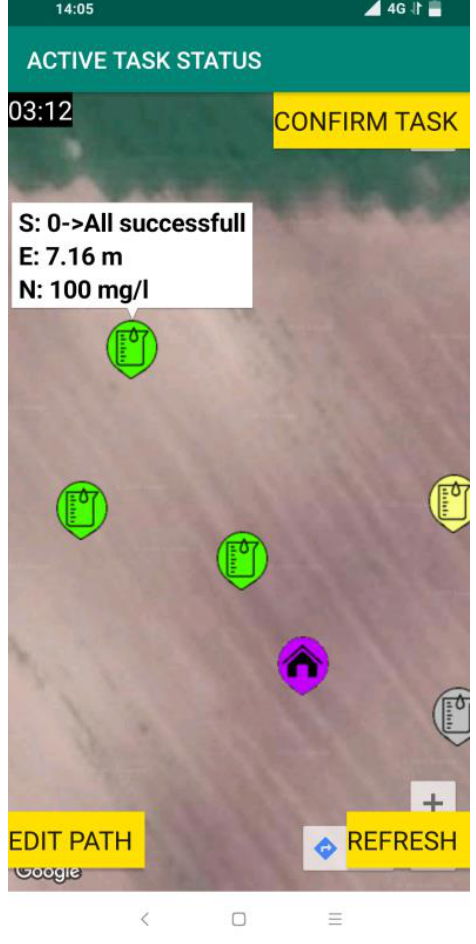
Figure 14. Active task status.